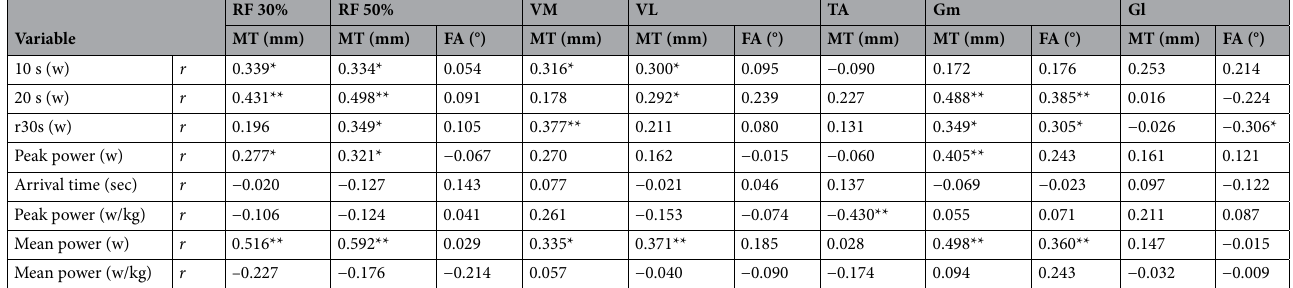
Table 3. Coefficients for Pearson’s correlations between muscle thickness and fascicle angle of lower leg region muscle and anaerobic power. R R-value; significantly different, *p < 0.05, **p < 0.01, RF rectus femoris, VM